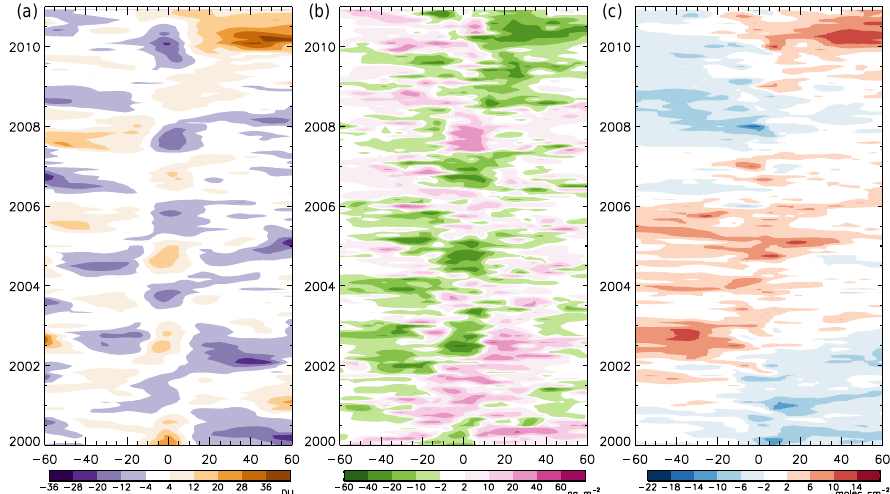
Figure 3. Deseasonalized monthly anomalies in the total ozone column (left), mean tropospheric OH (center), and CO column (right) from the EmFix simulation as a function of latitude and month.